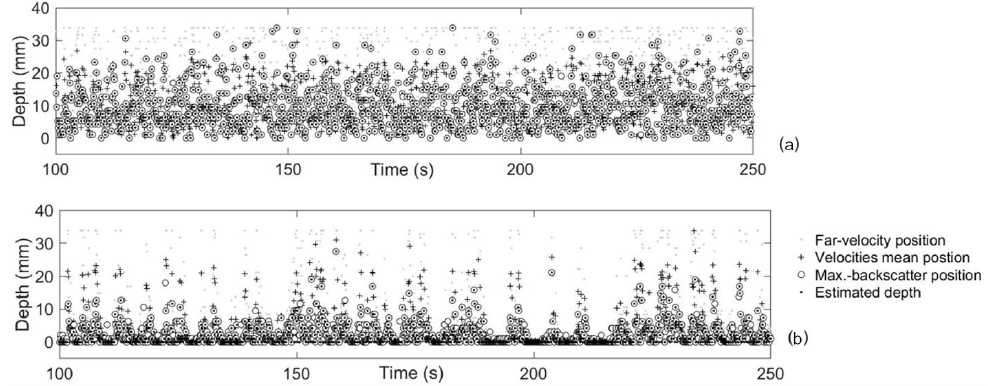
Figure 6. Estimated flow depth in time with positions of most far velocity, validated values of velocity (i.e., gates barycentre) and maximum backscatter: UVP analysis for test with R c / H s = 0 ( a ) and R c / H s = 1 ( b ).